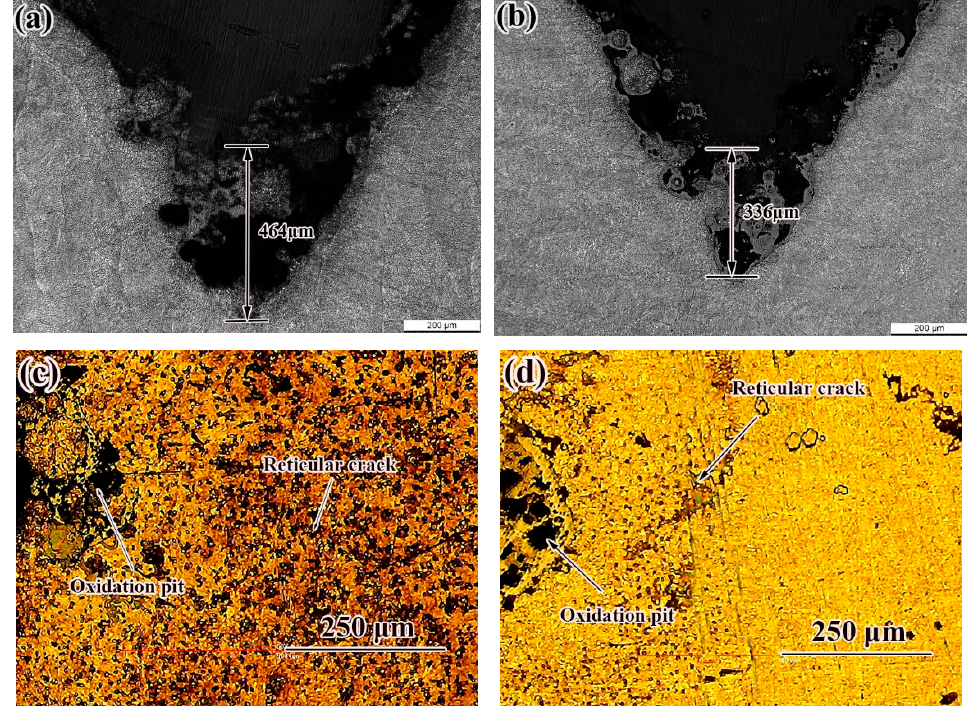
Figure 12. Crack morphology of samples in different states after thermal fatigue test: ( a , c ) as-deposited; ( b , d ) SR.